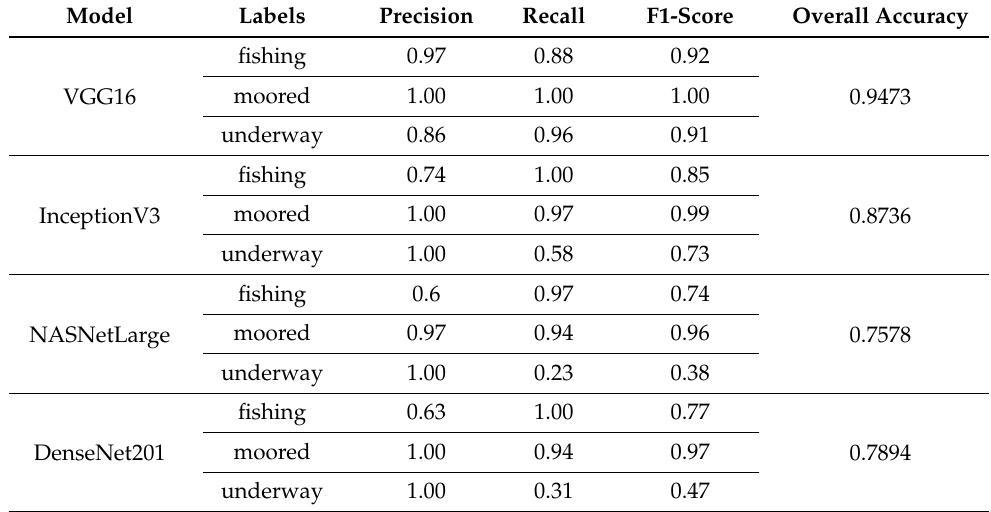
Table 5. Classification performance obtained from different pre-trained CNN models for Pattern